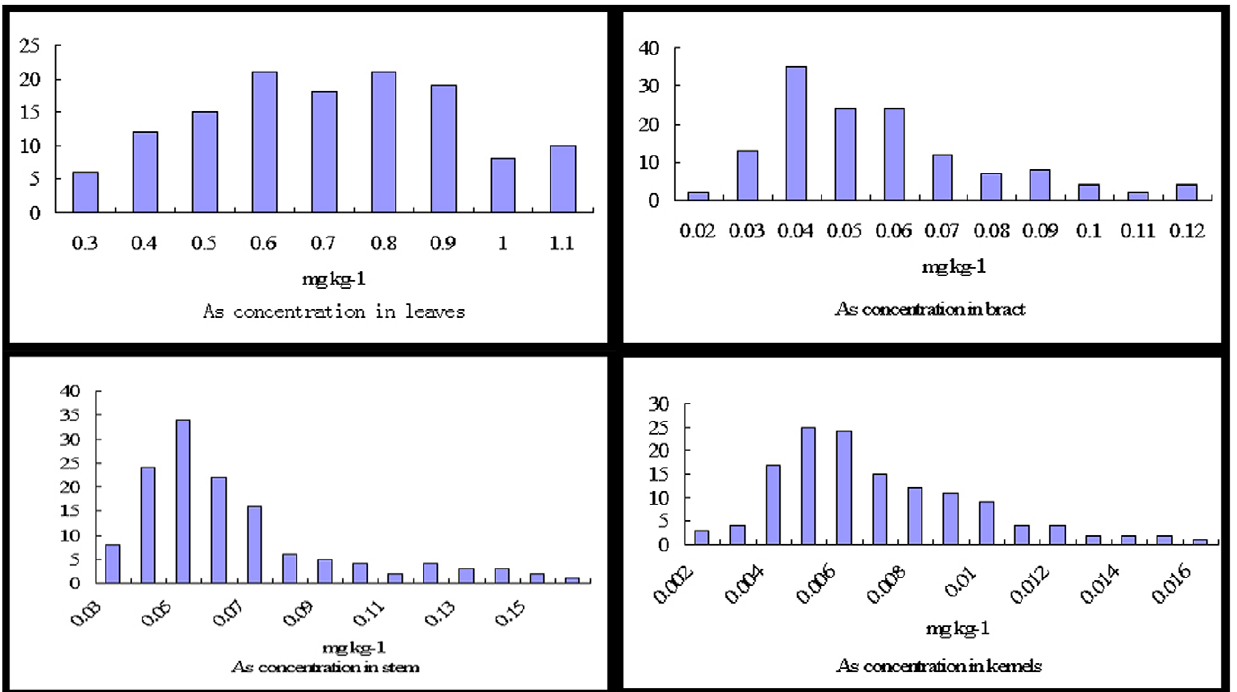
Figure 1. Histogram of As concentration in the four tissues of the RIL population.